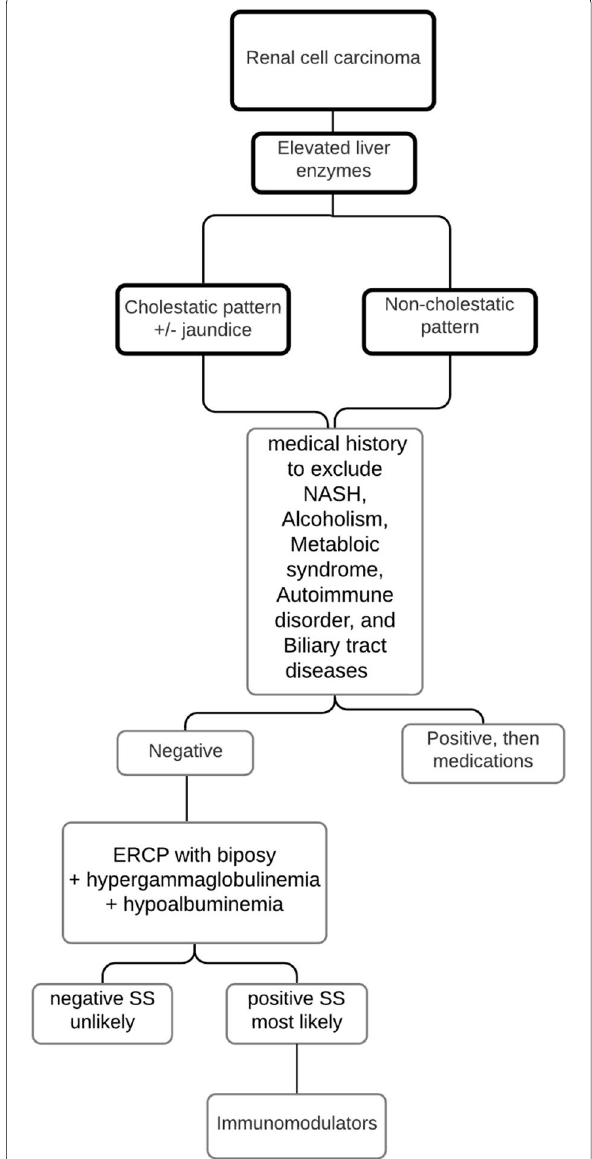
Fig. 2 Stauffer syndrome diagnostic plan proposal.